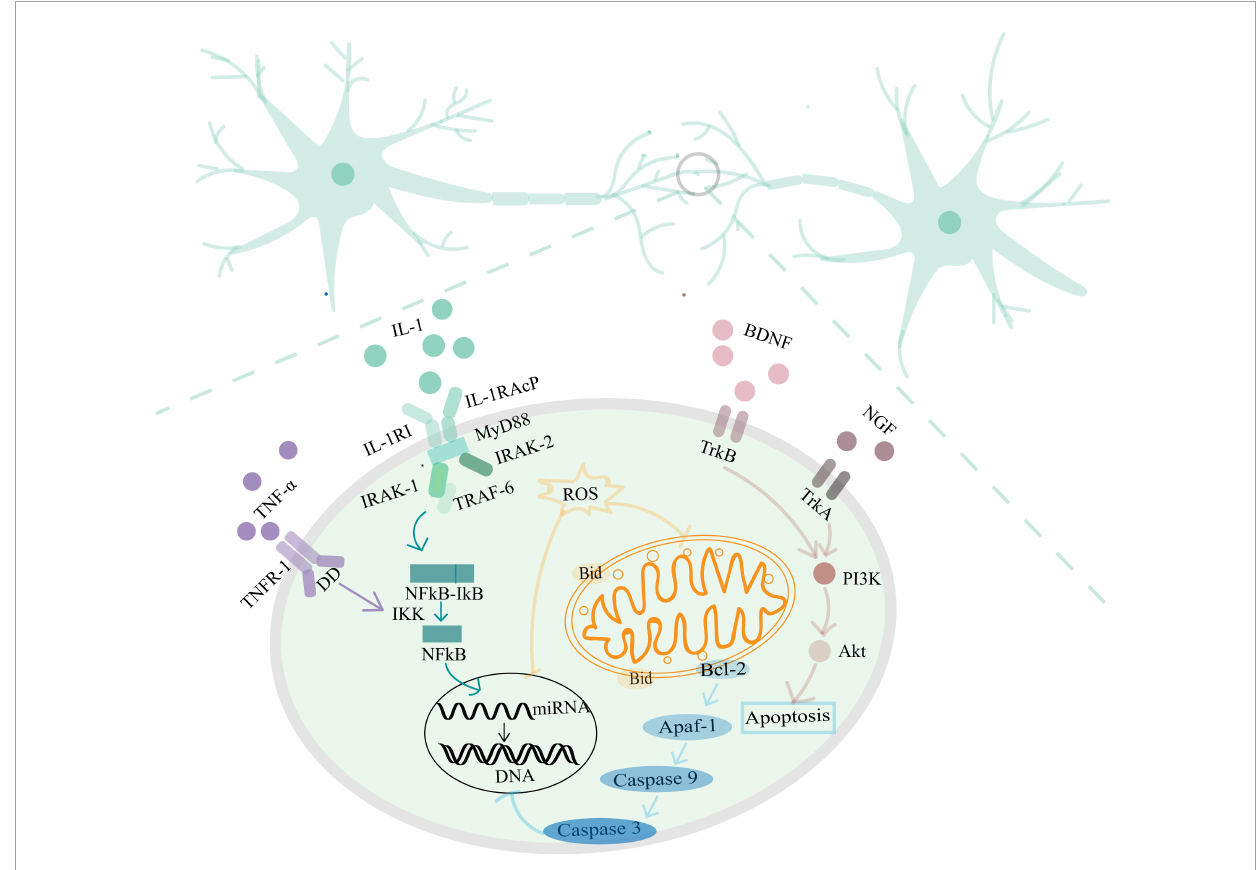
FIGURE2 The mechanism of the pathological damage of stroke influencing synaptic plasticity.